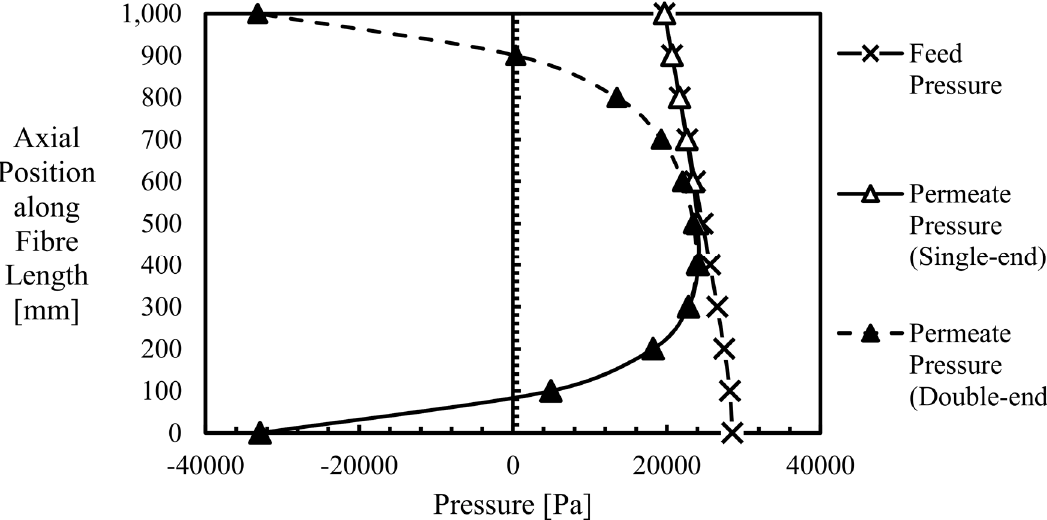
Figure 17. Feed and permeate pressure distribution of fibre with 0.3 mm inner diameter, 0.1 membrane thickness, and membrane permeability of 1.53 × 10 − 15 m 2 (1500 LMH/bar), in single-end and double-end suction. λ value of this fibre was calculated to be 10.98 m − 1 .